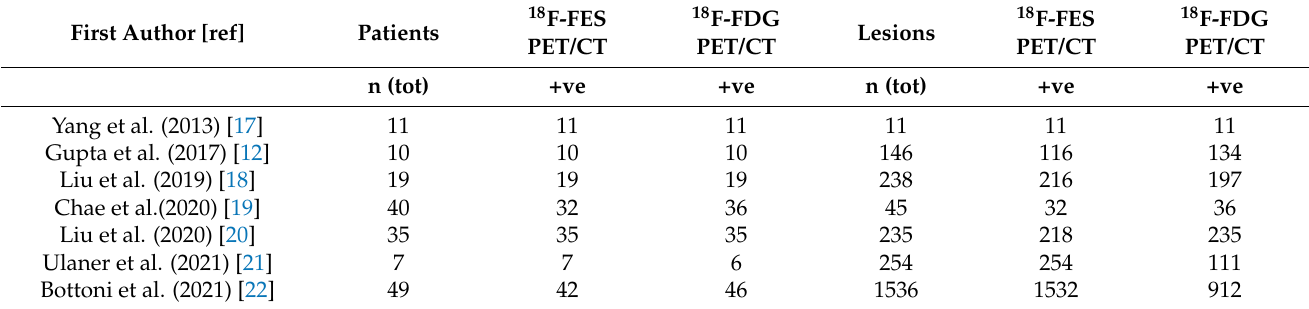
Table 3. Data available in the seven studies included in the present systematic review.